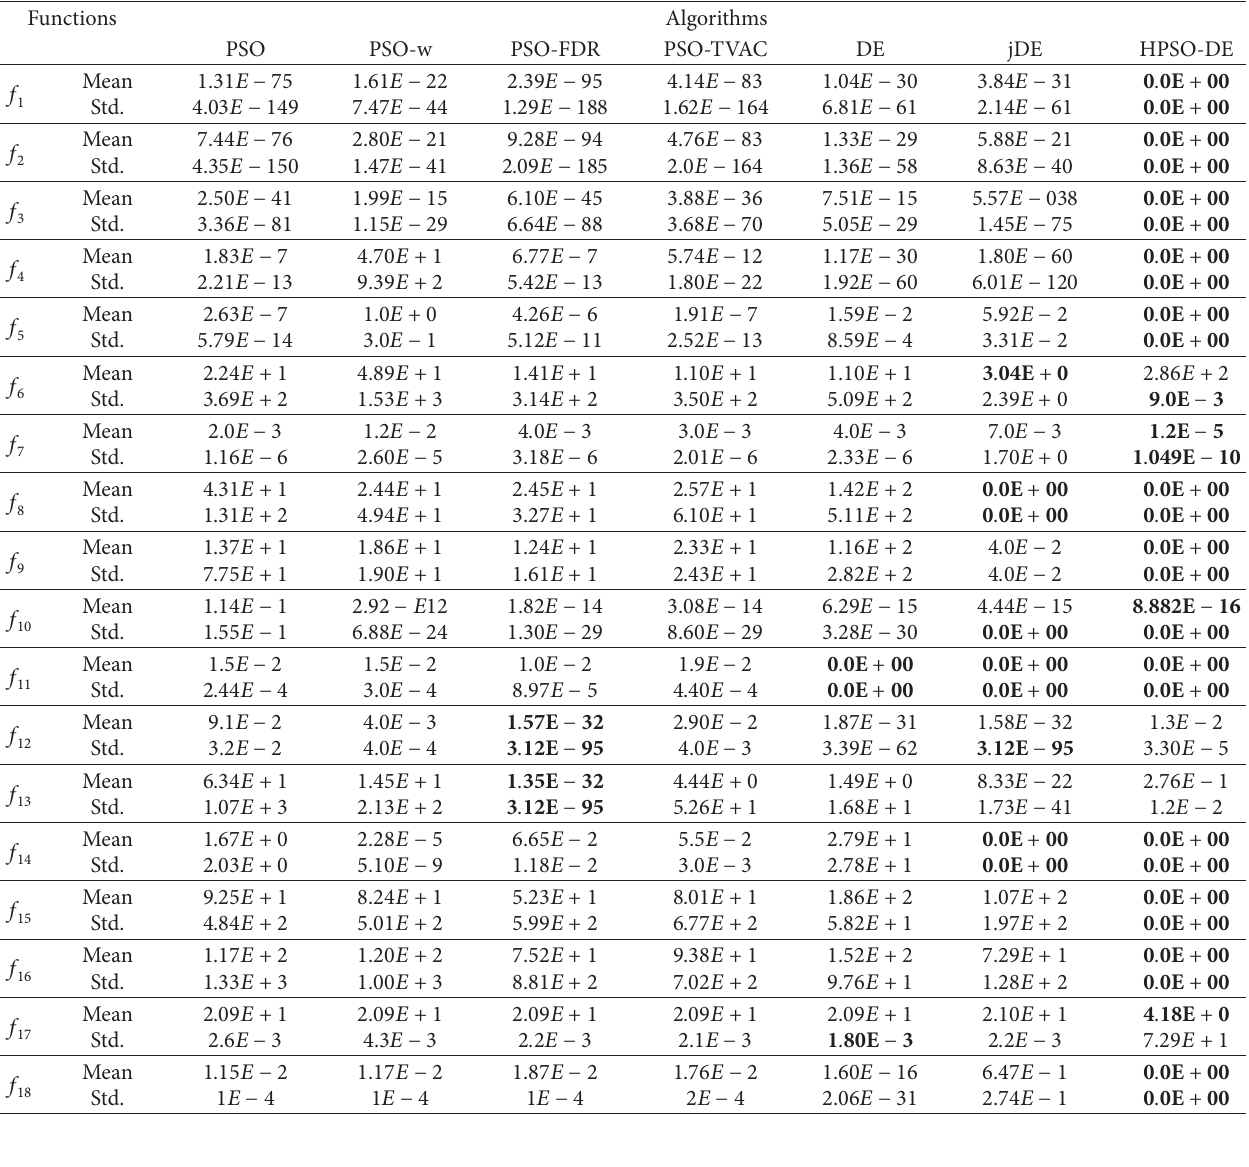
Table 3: Result comparisons among seven algorithms on test